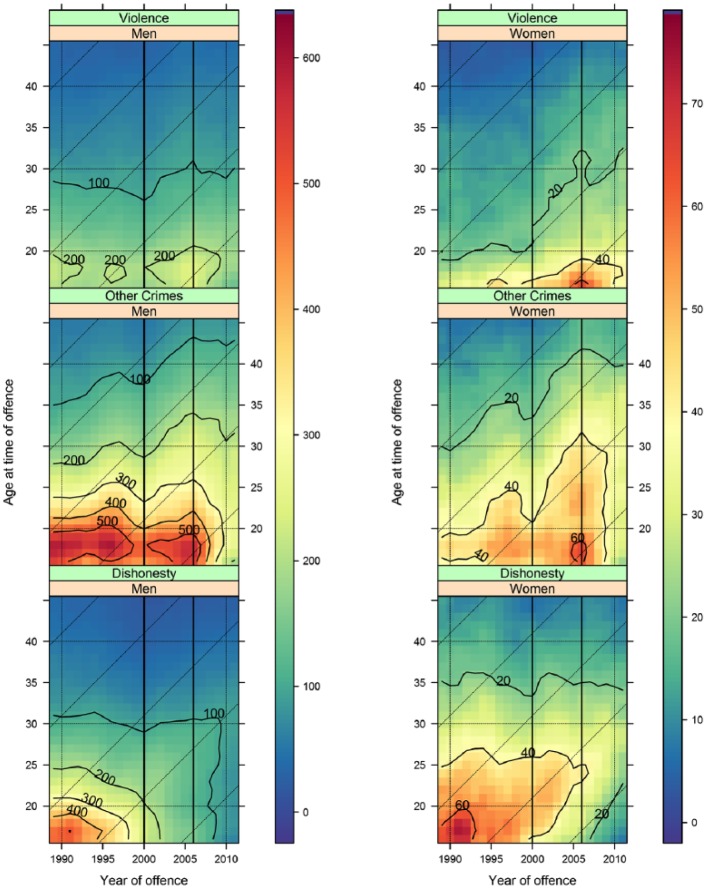
Shaded contour plot of convicted offences of different crime types in the SOI, 1989–2011.